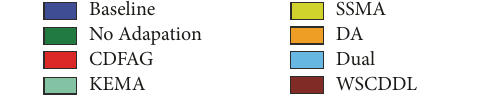
Figure 12: Comparison between our results and related